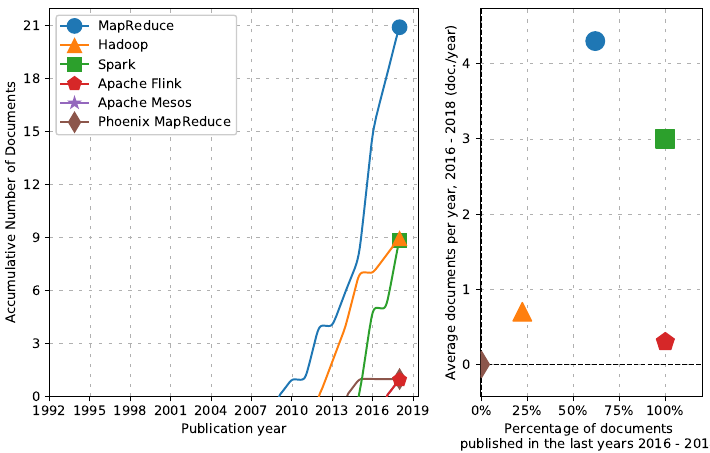
Figure 14. Big data top implementations in FPGA